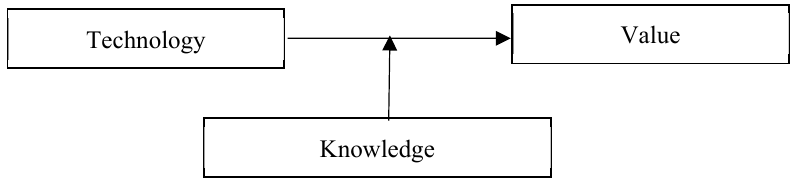
Figure 5. The schematic diagrams showing the positions of the independent (Technology), dependent (Value), and moderating (Knowledge) variables.